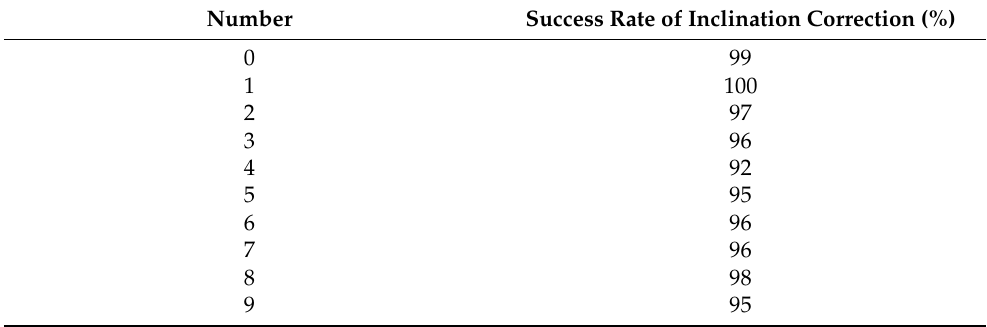
Table 4. Success rate when the digits and background are clearly separated in the binarized process.